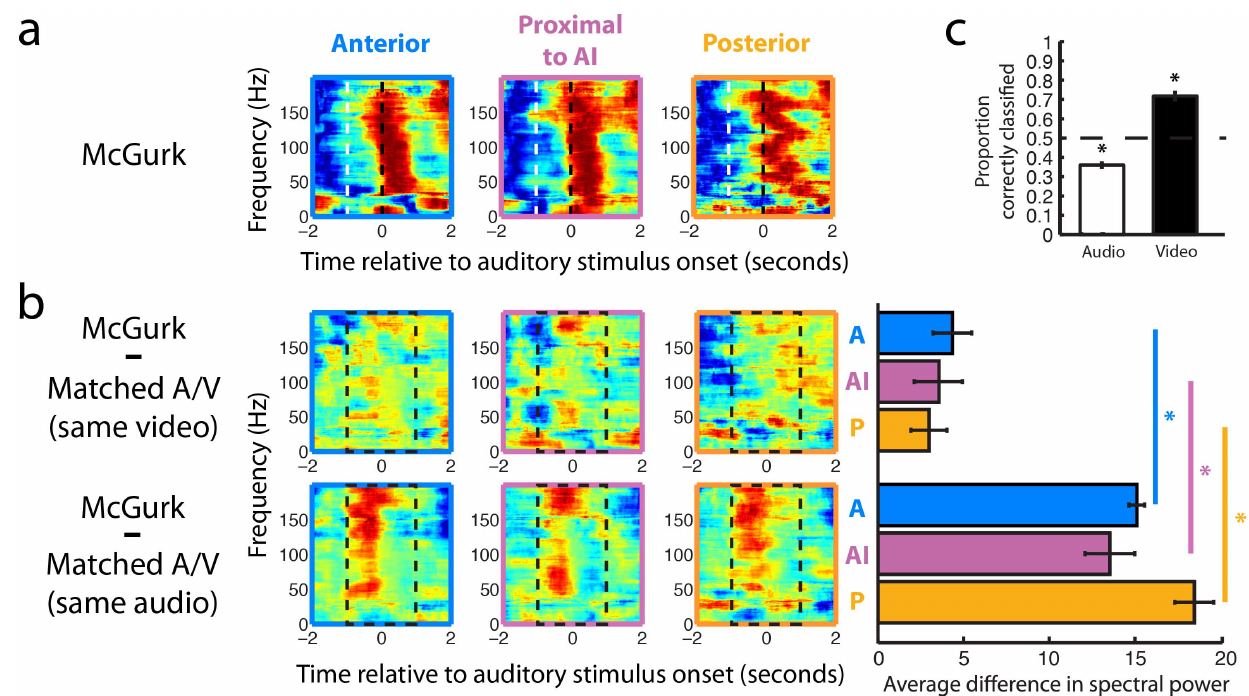
Figure 3. Visual representations in parabelt auditory cortex. a, Example spectrograms for the McGurk condition (‘‘VA’’ &/BA/). Spectrograms were normalized by frequency band. White dotted lines indicate the start of the video. Black dotted lines indicate the start of the audio. b, Example difference spectrograms for all three electrodes from one patient. Matched A/V spectrograms were subtracted from McGurk spectrograms (‘‘VA’’ &/ BA/ 2 ‘‘VA’’ &/VA/and ‘‘VA’’ &/BA/ 2 ‘‘BA’’ &/BA/) between 2 1 and 1 seconds relative to auditory stimulus onset (between black dashed lines in spectrograms). McGurk spectrograms were significantly less different from Matched A/V spectrograms with the same video identity than Matched A/ V spectrograms with the same audio identity, as shown in the bar graph to the left of the difference spectrograms. Electrode locations are color coded and labeled (A, anterior electrode; AI, electrode proximal to AI; P, posterior electrode). c, A statistical classifier accurately classified McGurk trials when tested on the identity of the video (74.33%); however, the classifier consistently chose the wrong auditory identity for McGurk trials (36.17%). The dashed line represents chance level classification (50.00%).